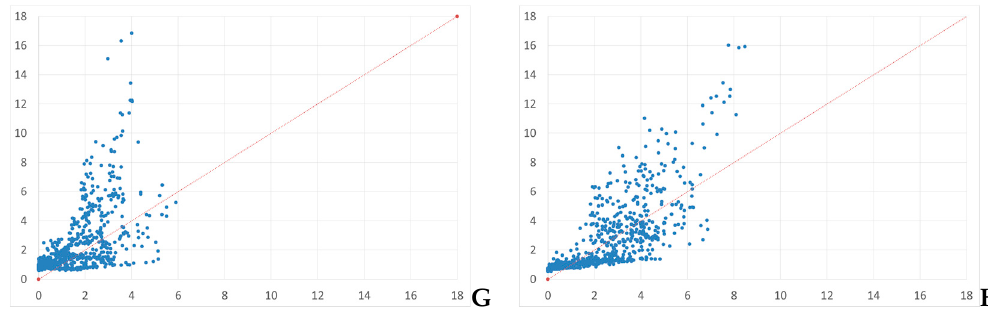
Figure 3. Comparison of observed discharges and snowmelt. ( A ) 3415: Vedretta Piana; ( B ) 4575: Rio Casies a Colle; ( C ) 4875: Rio Anterselva a Bagni Salomone; ( D ) 5497: Rio Riva a Caminata; ( E ) 2075: Rio Plan-Eschbaum; ( F ) 3585: Rio Racines a Stange; ( G ) 3355: Rio Vizze a Novale; ( H ) 3195: Rio Fleres a Colle Isarco. 1:1 lines represented in red with rounded tips.